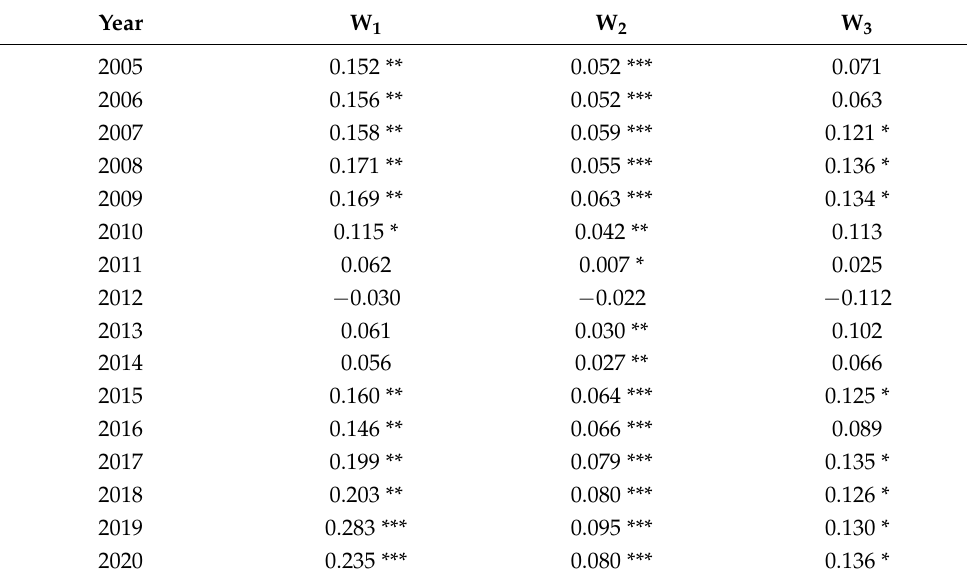
Table 2. Global Moran’s I under different spatial